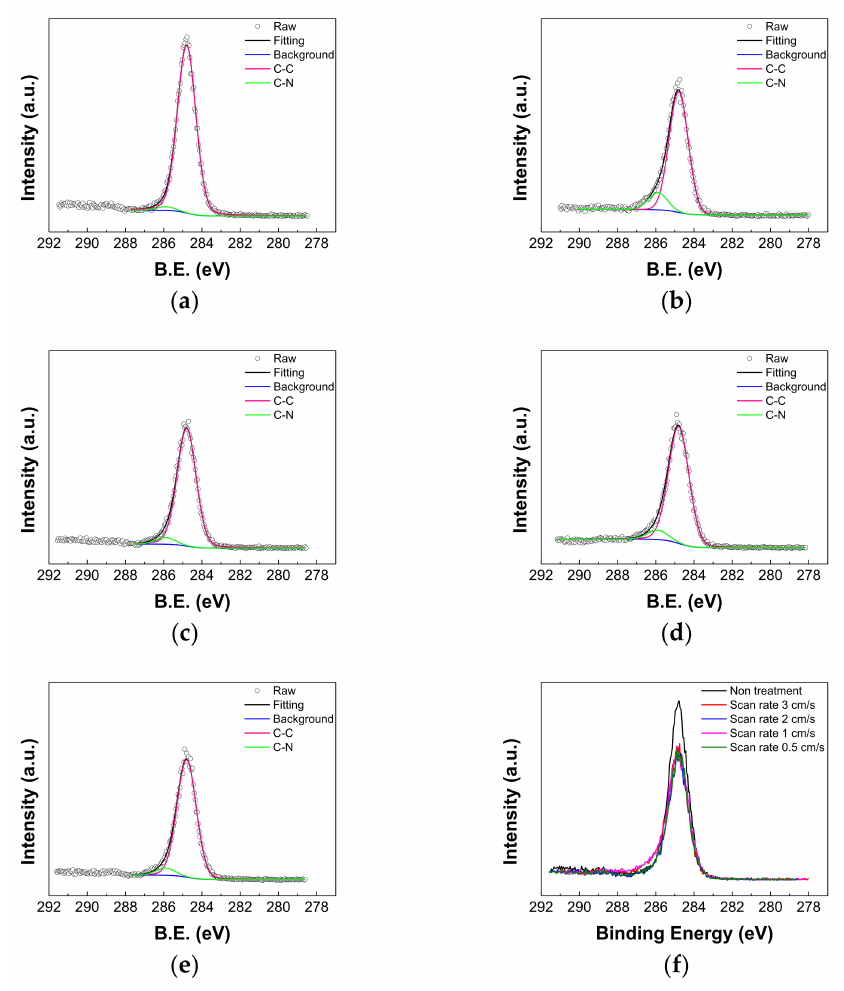
Figure 4. XPS of C1s spectra of BCP film ( a ) as-deposited and ( b – e ) with He DBDjet treatment with